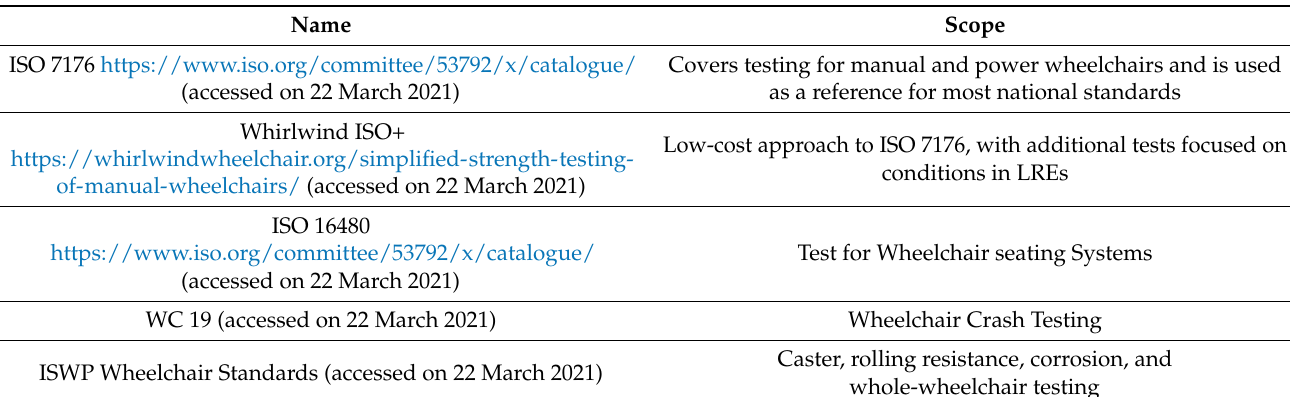
Table 1. Standardized